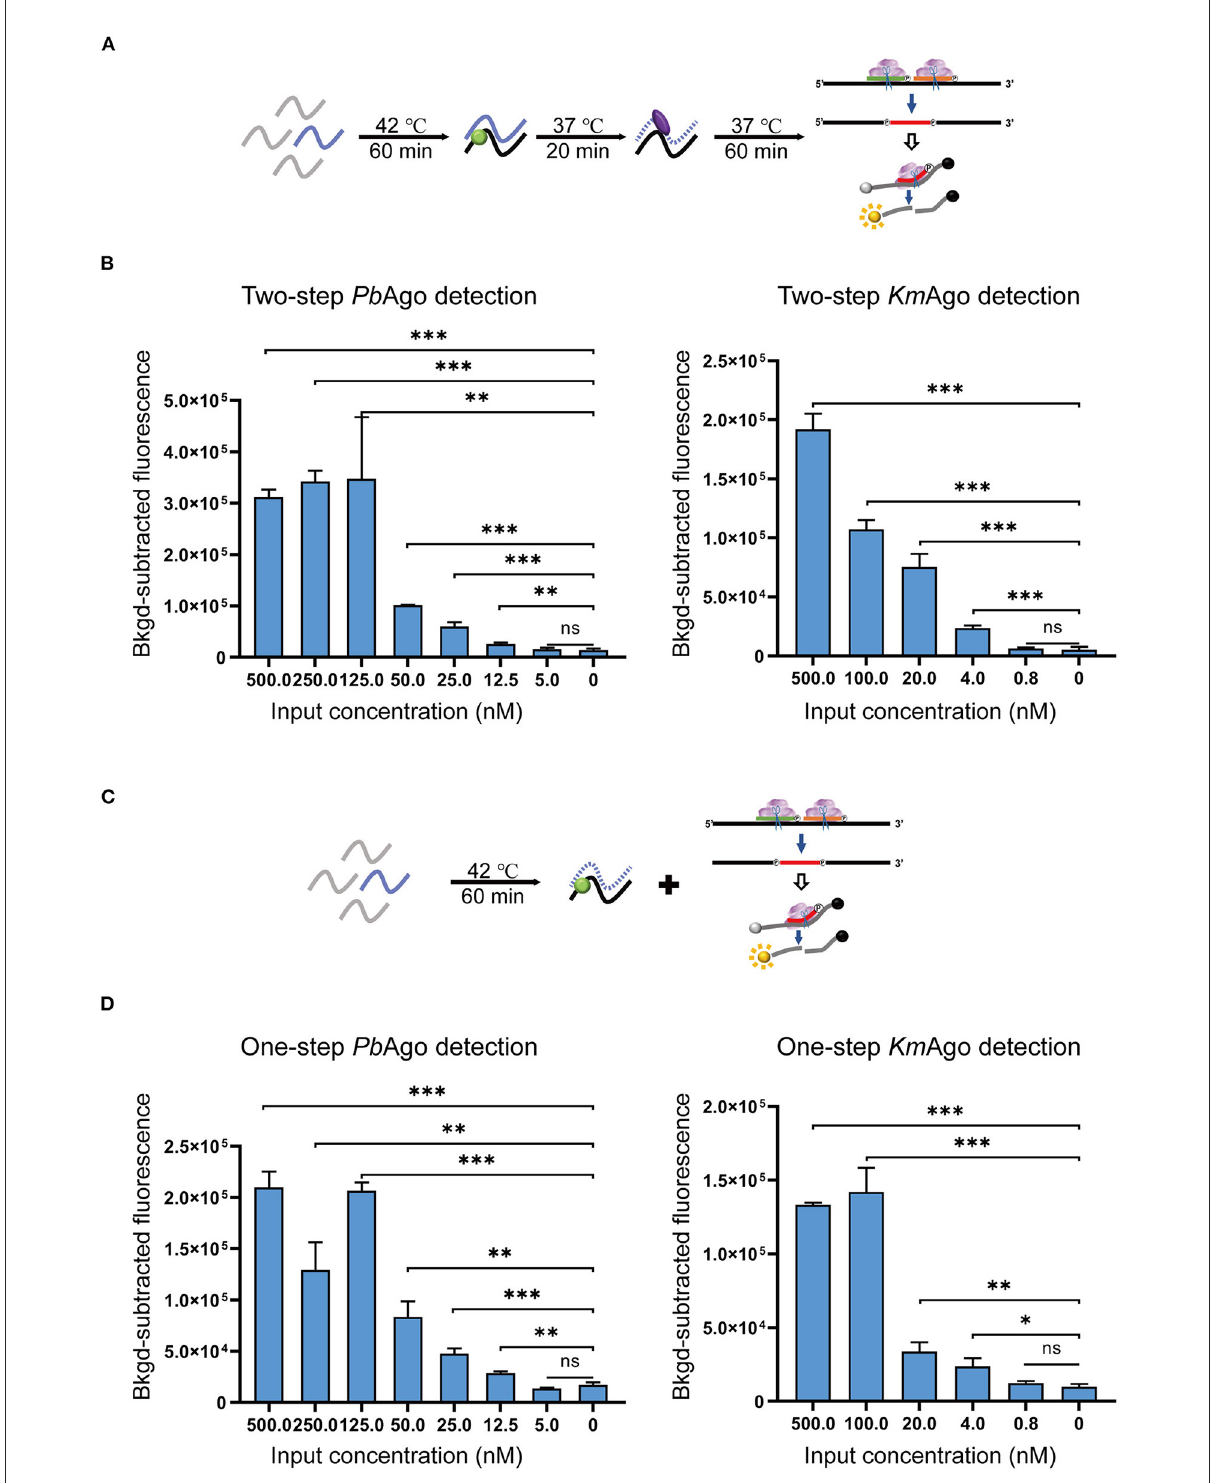
FIGURE4 Sensitivity evaluation of the MAIDEN system. (A) Schematic diagram of the two-step operation. (B) Sensitivity of the Pb Ago and Km Ago-mediated two-step assay. (C) Schematic diagram of the one-step operation. (D) Sensitivity of the Pb Ago and Km Ago-mediated one-step assay. Data were collected from three independent experiments and are presented as the mean ± SD, and significance was considered as ns ≥ 0.05, * p < 0.05, ** p < 0.01, and *** p <